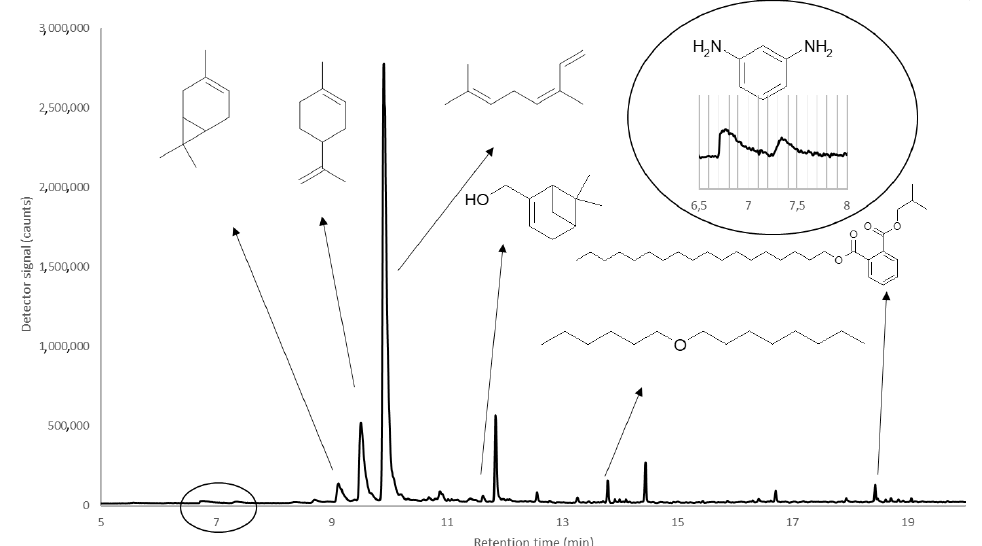
Figure 1. Chromatograms of the VOCs isolated from sample from control colony. The unlabelled peaks are typical degradation products of silane from polydimethylsiloxane fibre used in solid phase microextraction.